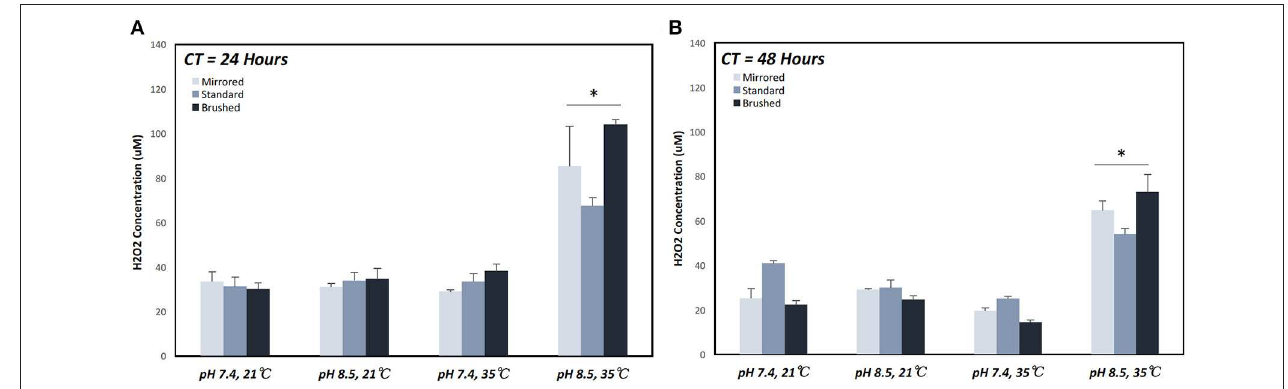
FIGURE 4 | Cumulative hydrogen peroxide release of pDA coatings created under various conditions over a 24h period. Hydrogen peroxide release measured over a 24h period on coupons coated for (A) 24 and (B) 48h. The highest release was seen on coupons coated with pDA using a pH 8.5 solution at 35 ◦ C for 24h. When coated for 48h there was a smaller increase in release when increasing temperature for pH 8.5 and a slight decrease in release for pH 7.4 with increasing temperature. *A significant difference from all other coating conditions within the surface finish ( p < 0.05). More broken-down results with all significant differences for individual surface finishes can be found in Supplemental Figure 2 . CT, coating time.